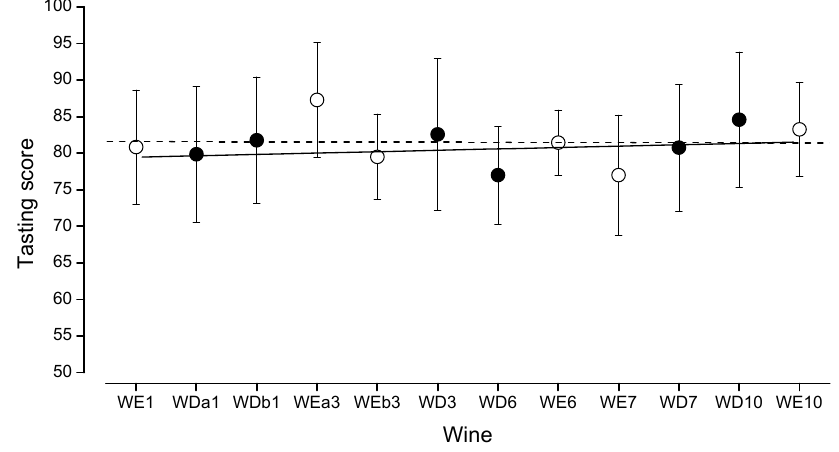
Figure 3. Evolution of the tasting scores given by the 2014 panel to white wines (“easy” wines, open symbols; “difficult” wines, filled symbols). Straight lines were obtained by linear regression of mean score values (“easy wines”, dashed lines; “difficult” wines, solid lines). Bars indicate standard deviations of the mean scores. Wine references are described in Table 4.